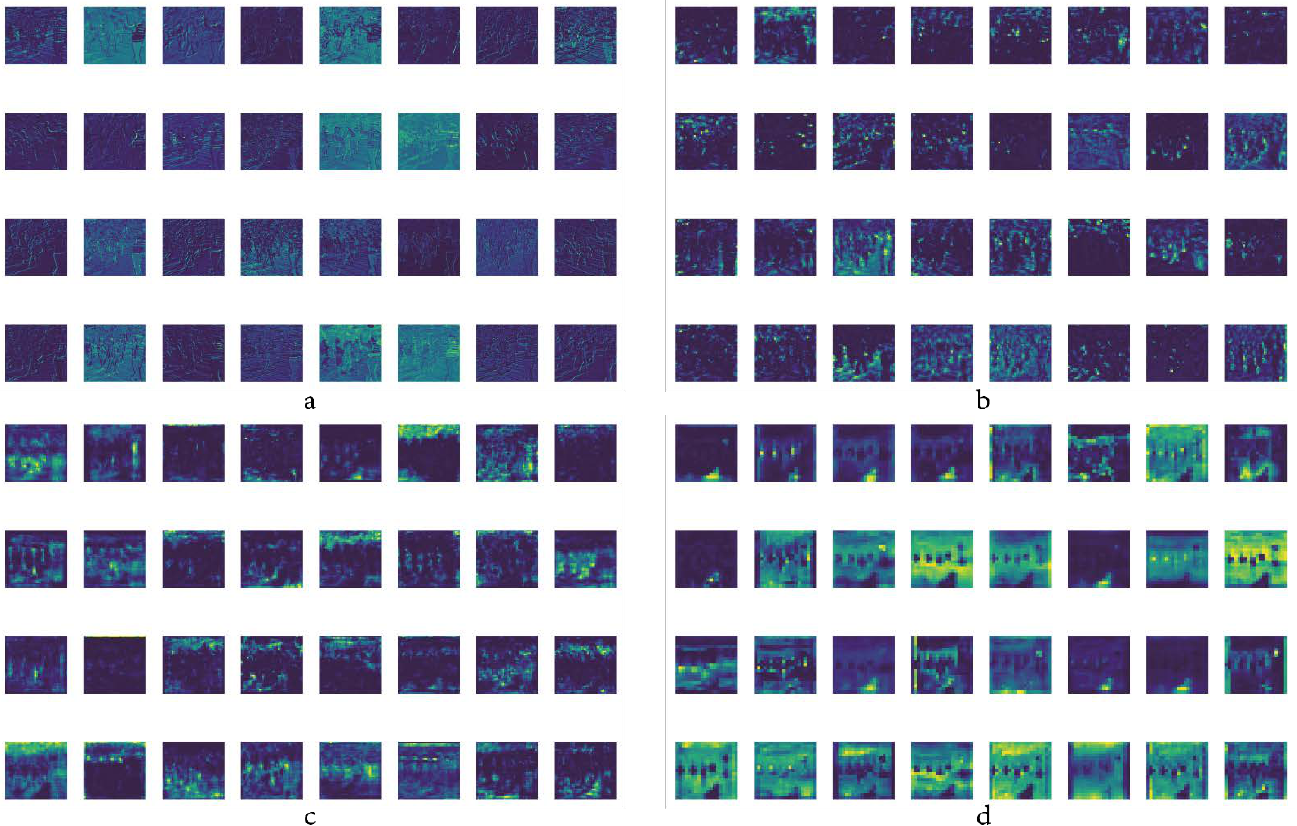
Figure 21. Visualization of feature maps. ( a ) stage1_C3 feature maps; ( b ) stage6_C3 feature maps; ( c ) AC_FPN feature maps; ( d ) output feature maps.